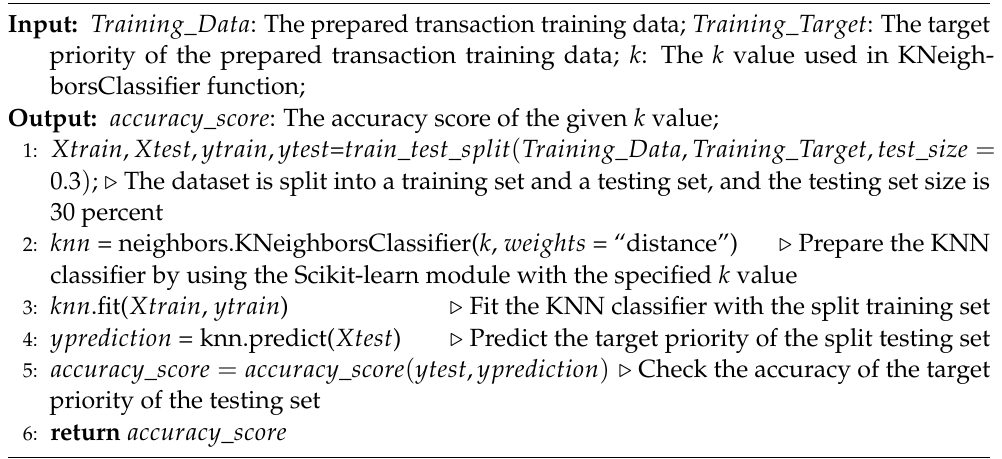
Algorithm 4 KNN k value selection with a single training/test set